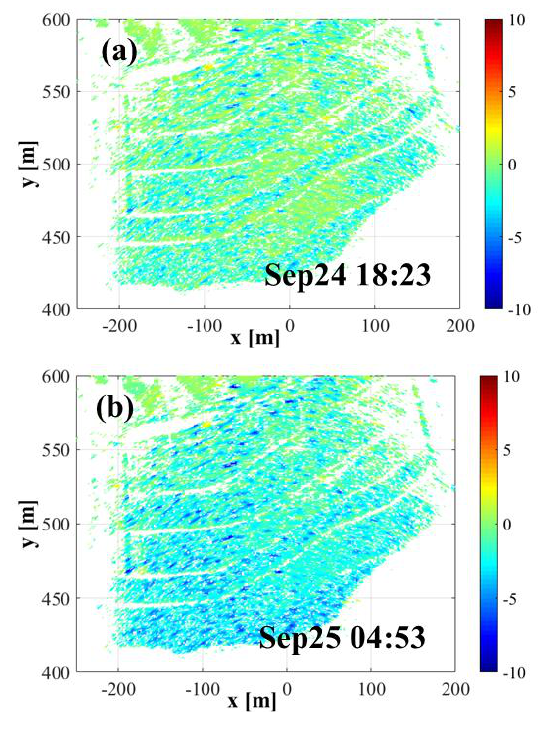
Figure 4. Power image of the monitoring